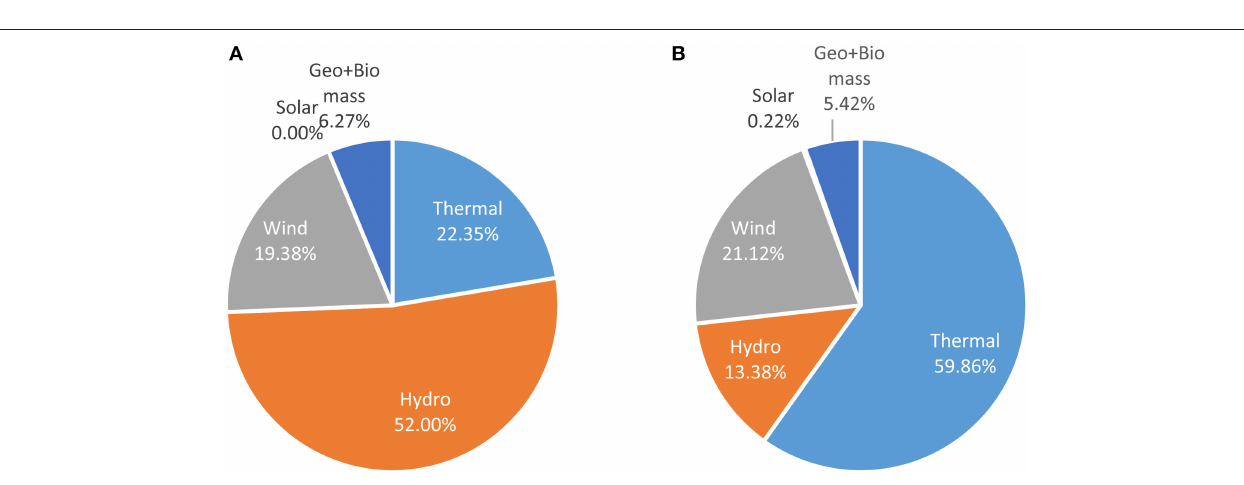
FIGURE 9 | Newly installed electricity generation capacity (A) in 2015, (B) 2016 Source: MENR 18